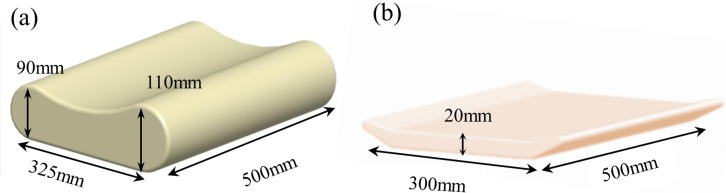
Design and dimensions of the pillow (A) and elevation mats (B).